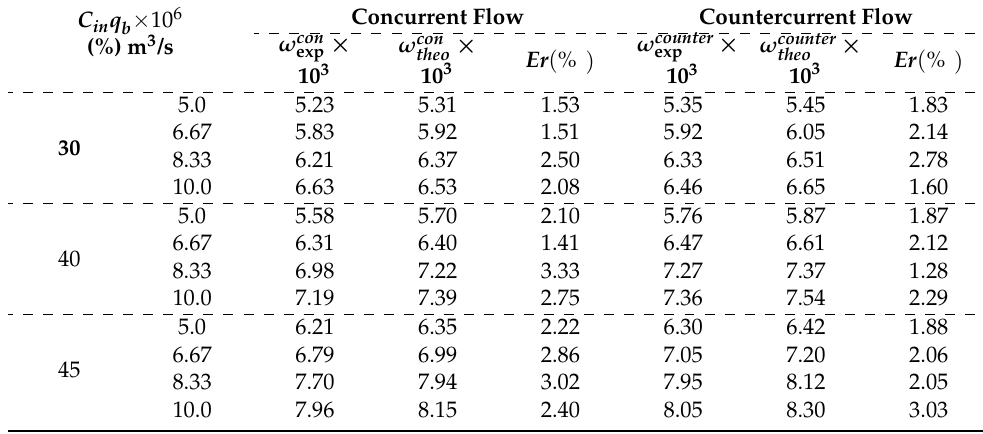
Table 1. The accuracy deviation between theoretical predictions and experimental